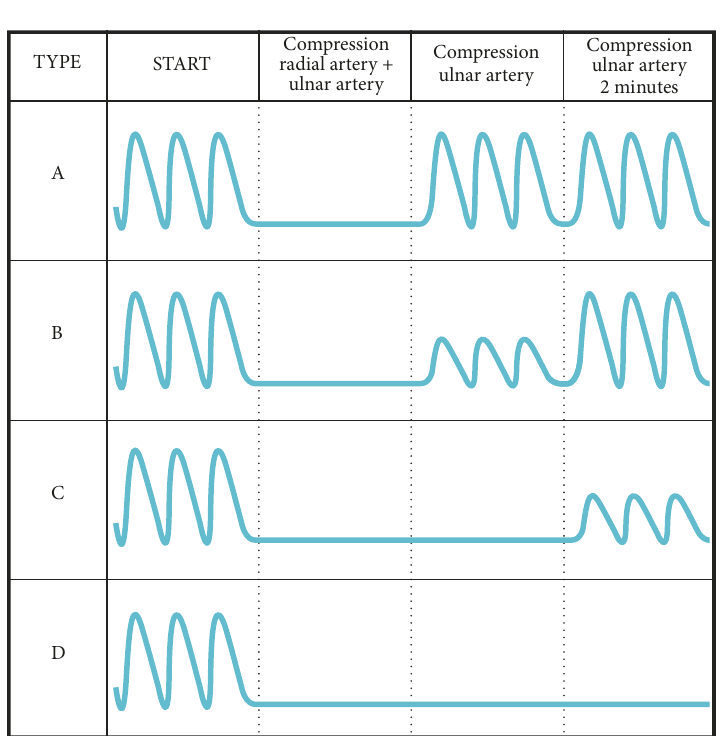
Figure 1: Flowchart.